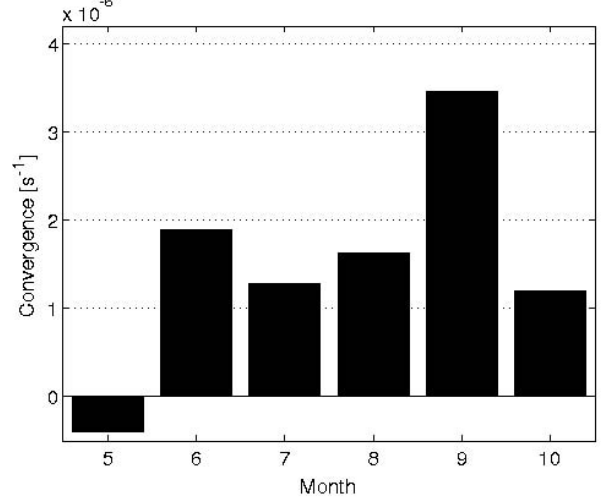
Fig. 11. Monthly variability of convergence averaged over the